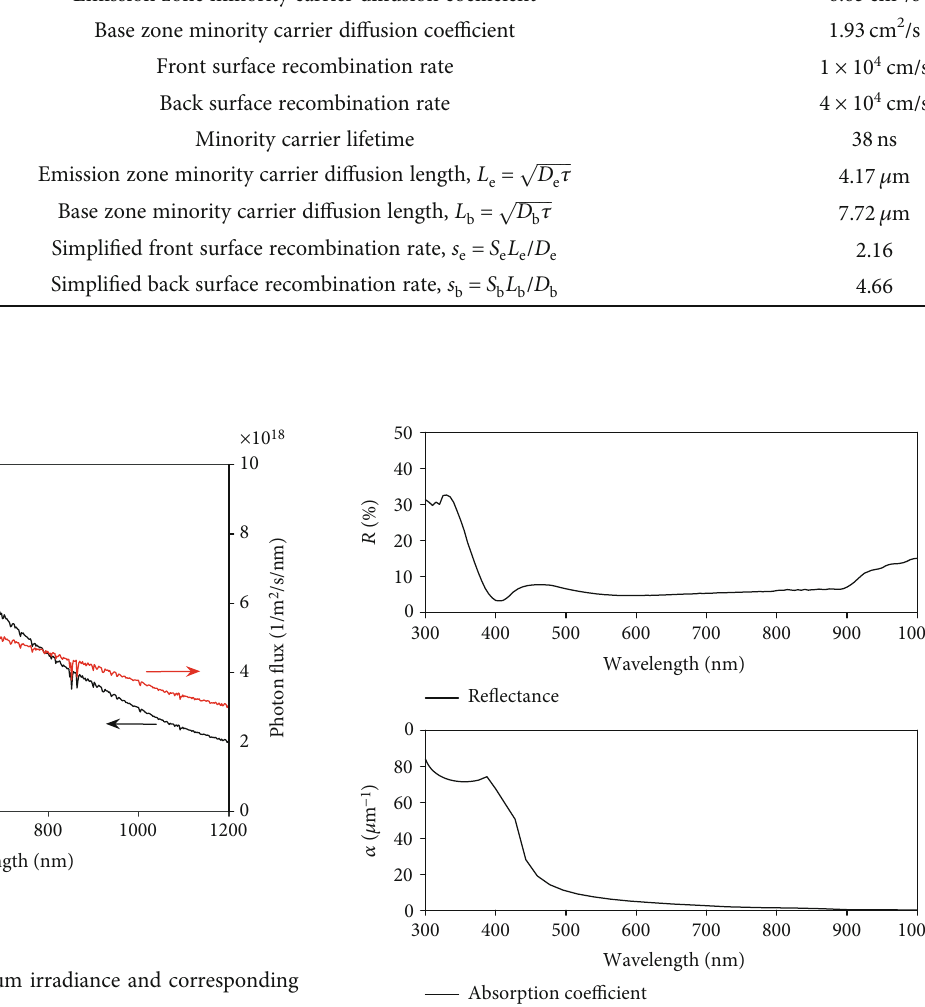
Figure 5: The photon absorption coe ffi cient of GaAs and front surface re fl ectance of the solar cell before